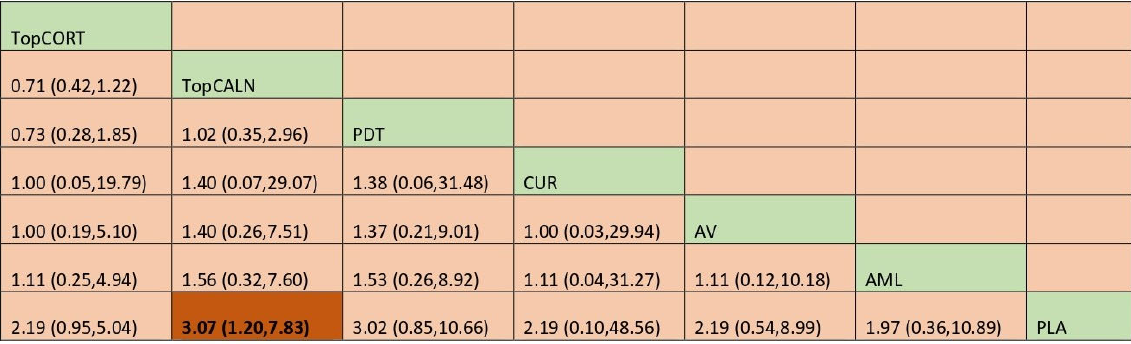
Figure 10. Network Plot: Clinical Score. Abbreviations: AML, amlexanox paste; AV, aloe vera; CUR, curcumin gel; PDT, photodynamic therapy; PLA, placebo; PUR, purslane; SysCORT, systemic cor ‐ ticosteroid; TopCALN, topical calcineurin; TopCORT, topical corticosteroid; HA, hyaluronic acid.